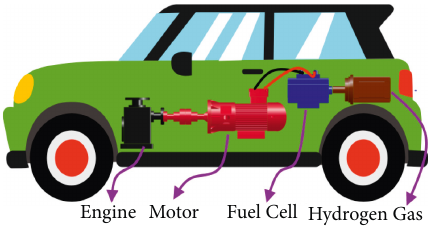
Figure 5: Fuel cell electric vehicle (FCEV).